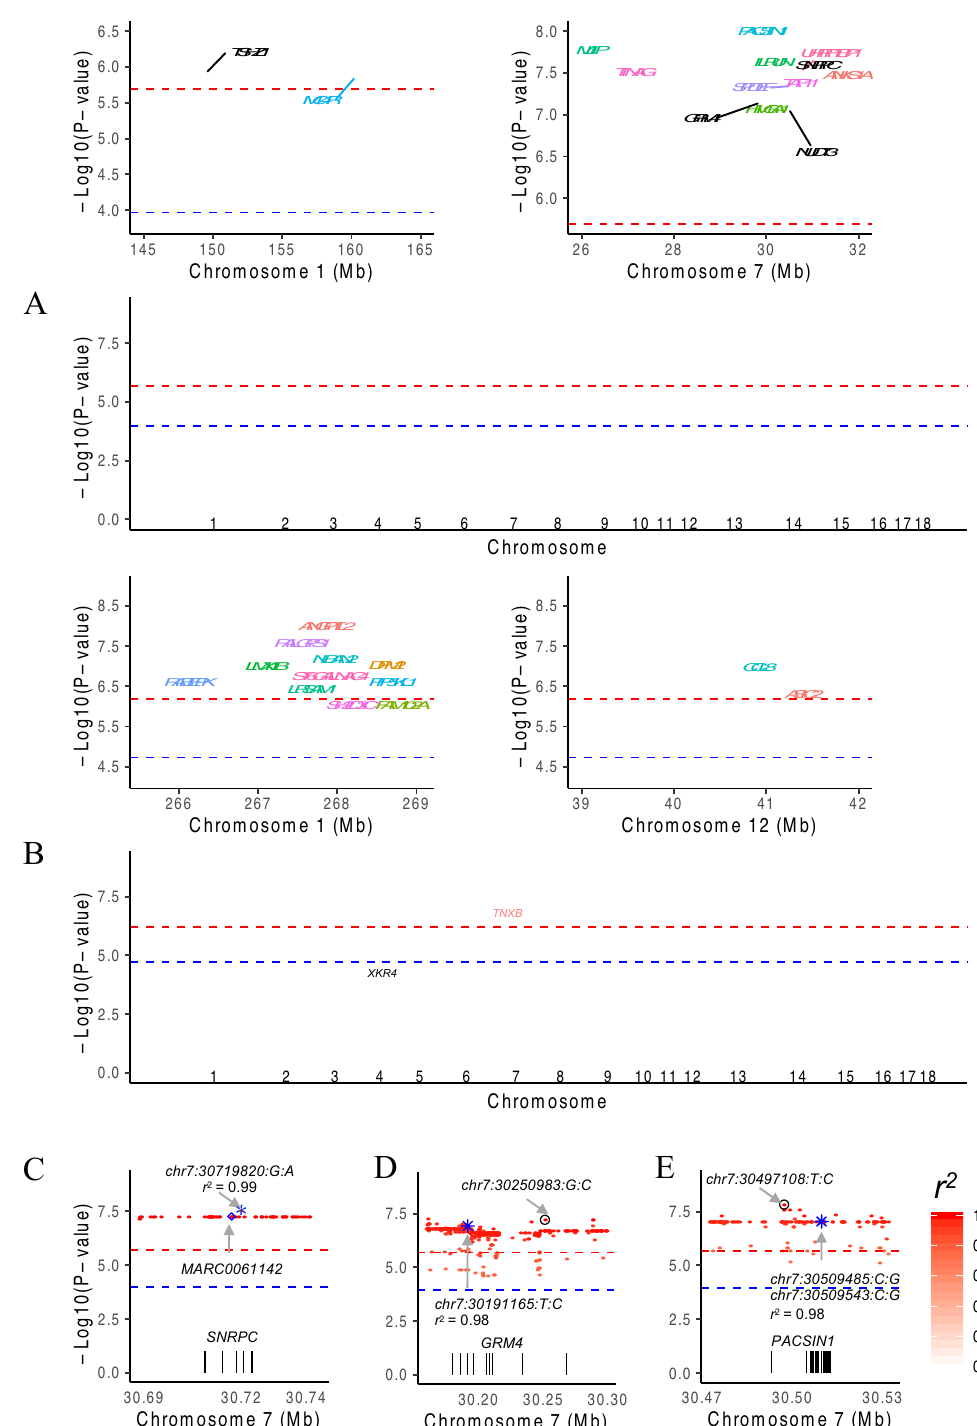
Figure 3. Association signals for growth phenotypes before and after imputation. Association test statistics on the − log10 ( P -value) scale (y-axis) are plotted for each SNP position (x-axis) for the trait of backfat thickness at an age of 180 days ( A ), from Zhang et al., and at 100 kg ( B ), from Fu et al. To simplify the plot, only the variants with a P -value less than 1.08 × 10 −4 are shown, and they are colored according to the annotated genes. The black-labeled genes are reported in the original paper, and the blue-labeled genes are novel genes detected after imputation. Examples of potential causal variants (marked by blue asterisks) in the SNRPC ( C ), GRM4 ( D ) and PACSIN1 ( E ) genes. Each dot represents a variant, whose LD ( r 2 ) with the Chip SNP (marked by blue diamonds) or the one with the lowest P -value (marked by a black circle) is indicated by the colour of the dot. The two horizontal lines divide SNPs with P -values < 2.05 × 10 −6 and < 1.08 × 10 −4 ( A ), and P -values < 6.46 × 10 −7 and < 1.86 × 10 −5 ( B